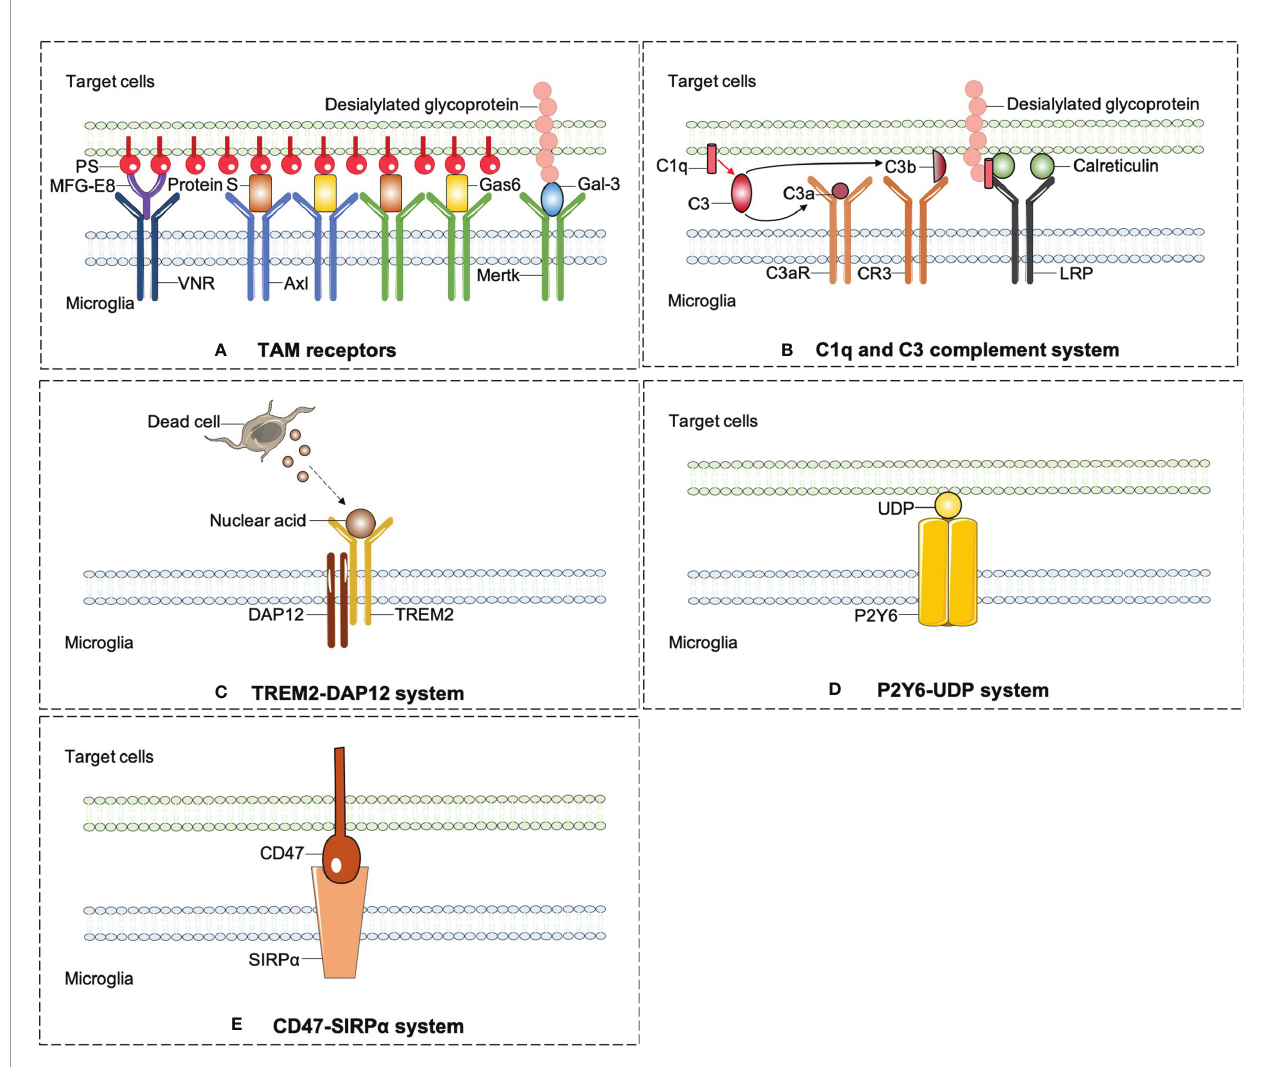
FIGURE 2 | The emergent eat-me/opsonins/phagocytic receptor systems in ischemic stroke. (A) Axl and Mertk of TAM receptors were widely expressed on microglia and can identify the best-known “ eat-me ” signal-PS. PS induces phagocytosis by activating VNR via MFG-E8 or TAM receptors via GAS6 or protein S. In addition to PS, Mertk also binds to desialylated sugar chains of stressed or dying neuronal cells through Gal-3, another opsonin which is rapidly released from activated microglia. (B) C1q mediates phagocytic recognition by means of binding to desialylated glycoproteins on targeted cell surface, and cooperatively activates LRP on microglia with the combination of calreticulin. Additionally, C1q triggers a protease cleavage and leads to the deposition of C3b, which directly activates CR3 on microglia. (C) TREM2-DAP12 signaling is involved in phagocytosis by microglia and plays a bene fi cial role in ischemic stroke. (D) P2Y6 receptors on microglia is activated by UDP released from damaged neurons and triggers microglial phagocytosis. (E) CD47-SIRP a signaling can inhibit the microglia engulfment property which may aggravate ischemic